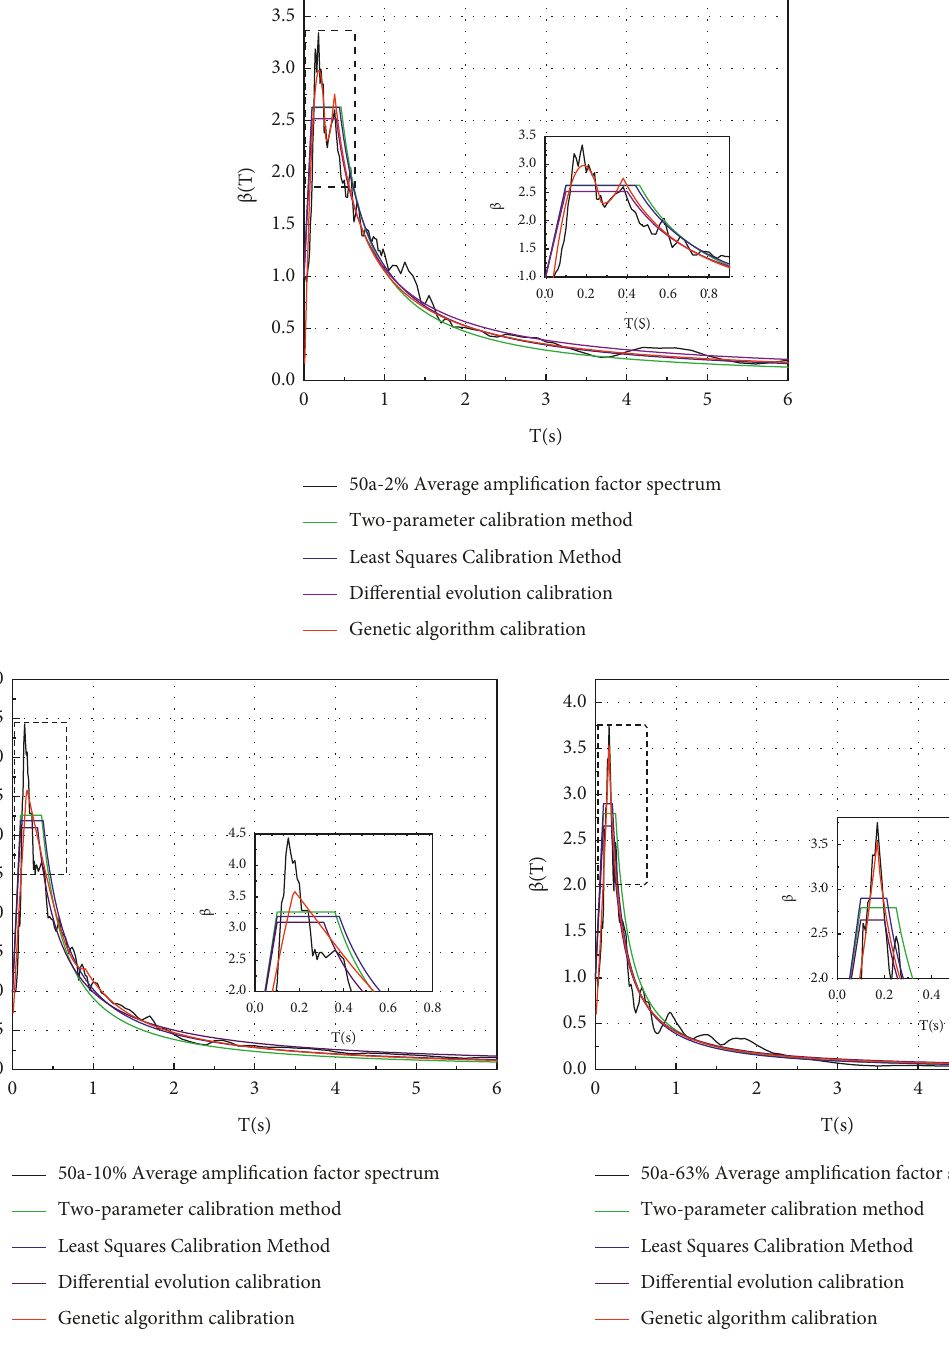
Figure 7: Comparison of calibration curves under three exceeding